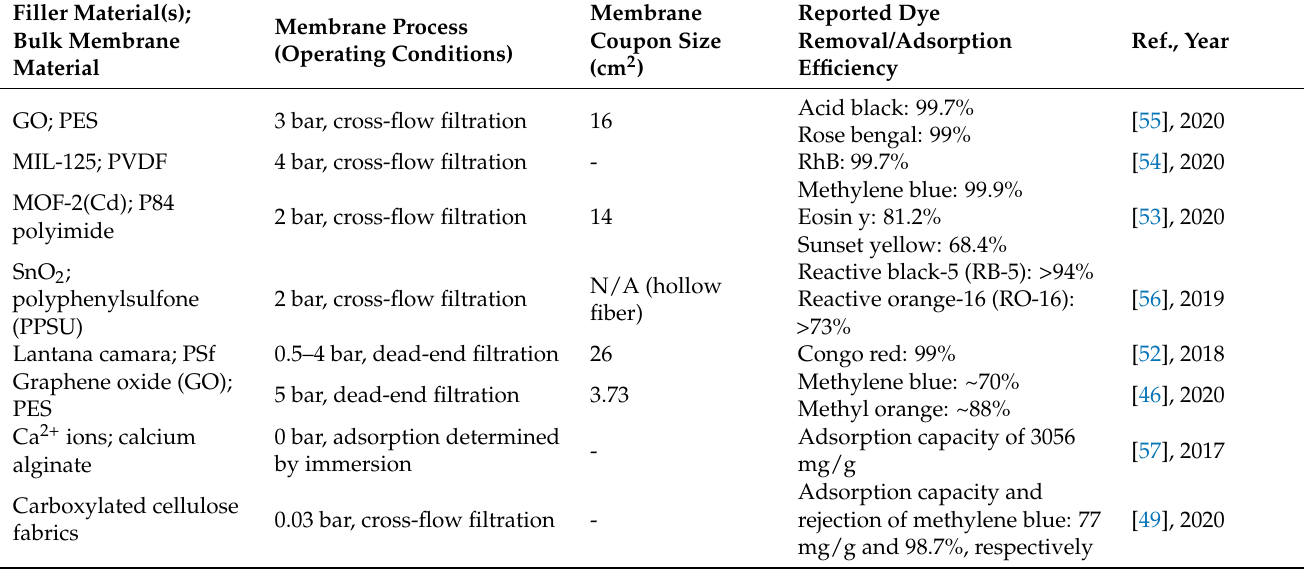
Table 2. A summary of emerging materials used to fabricate MMMs for enhanced dye